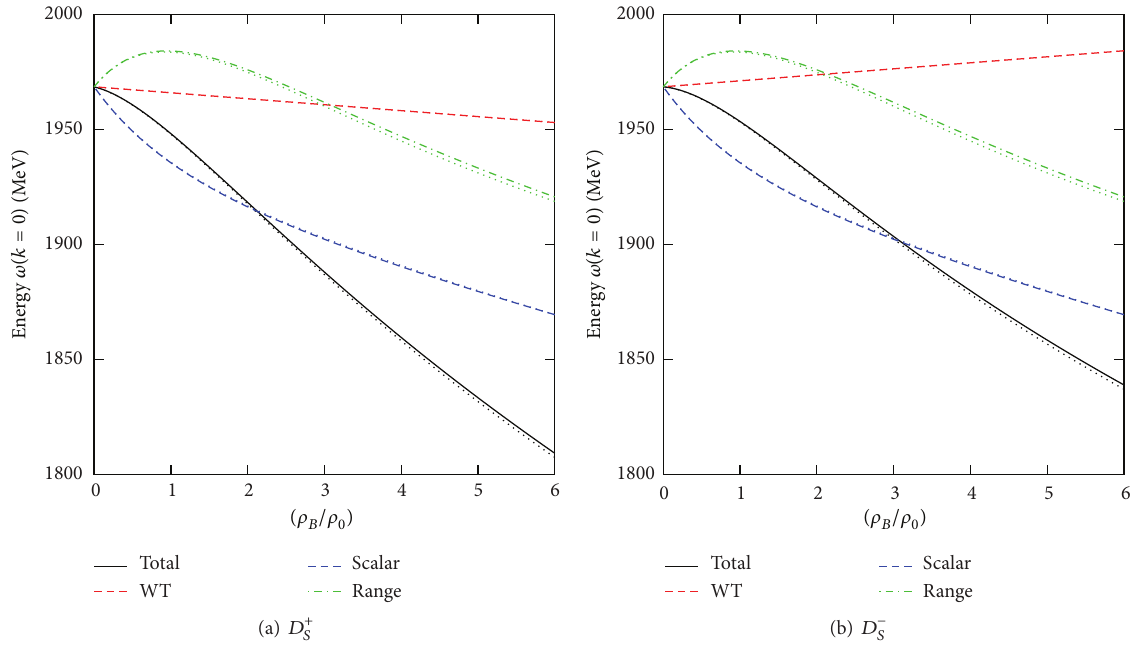
Figure 2: The various contributions to the effective mass of 𝐷 + 𝑆 and 𝐷 − 𝑆 mesons, as a function of baryonic density, for typical values of temperature ( 𝑇 = 100 MeV) and strangeness fraction ( 𝑓 𝑠 = 0.5 ). In each case, the asymmetric situation ( 𝜂 = 0.5 ), as described in the legend, is also compared against the symmetric situation ( 𝜂 = 0 ), represented by dotted